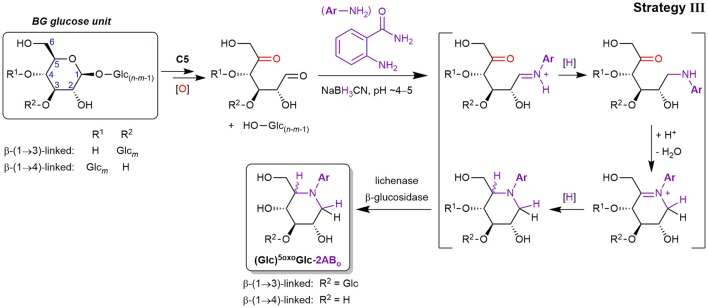
Lytic C5-oxidation forming a new terminus 5oxoGlc under loss of the non-reducing end-portion of the β-glucan polymer, and its reductive amination with 2-aminobenzamide (2-AB) (C=O labeling strategy III). The shown mechanism explains the cyclic end products 5oxoGlc-2ABo and Glcβ(1→3)5oxoGlc-2ABo detected in SPE fraction 1), which involves two reductive amination steps to form the piperidine derivative (first intermolecular tagging of the reducing end carbonyl (C1), then intramolecular with the C5-ketone). Glc, Glucose; [O], oxidation (Fenton-induced); [H], reduction (hydride from NaBH3CN).